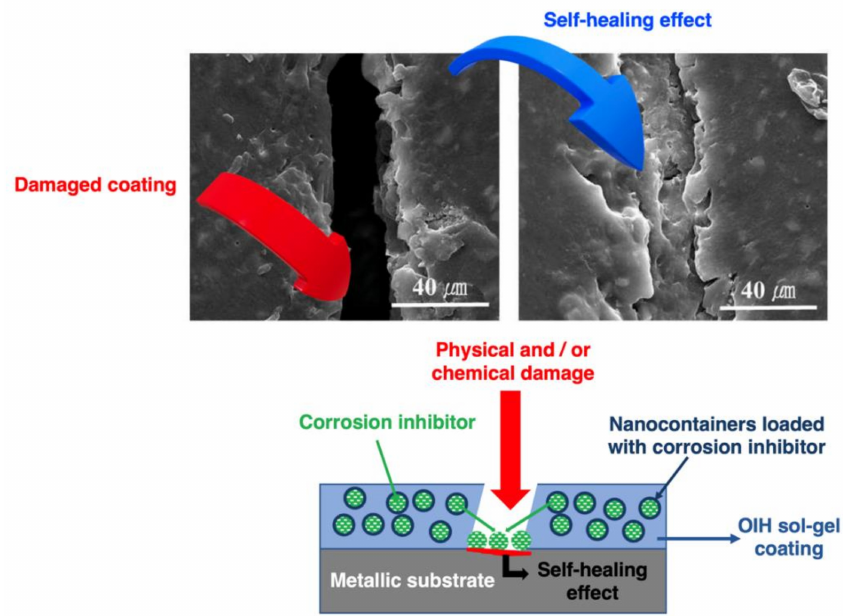
Figure 5. Schematic of corrosion self-healing mechanism with an OIH sol–gel coating containing nanocontainers loaded with corrosion inhibitors. Adapted from